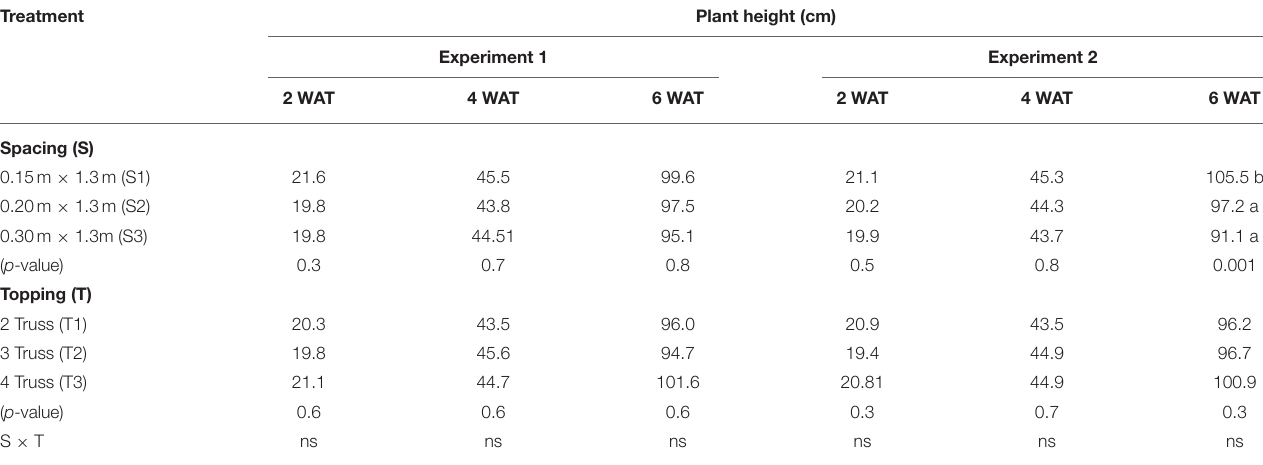
TABLE 2 | Effect of spacing and topping on plant height of Solanum lycopersicum under greenhouse conditions. Treatment